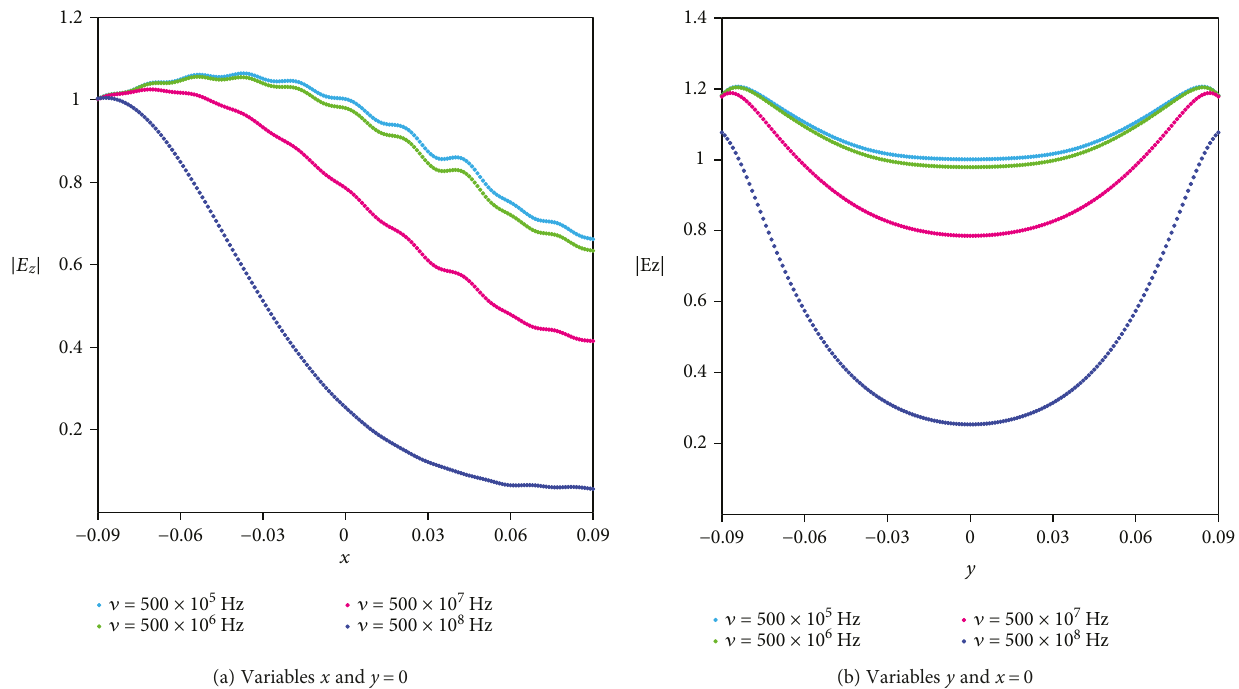
Figure 19: Magnitude of the electric fi eld, in volts/meter, inside the plasma for linear cuts through the cylinder obtained by the FDTD simulation for di ff erent collision frequencies ν . Incident wave frequency is set to f n =5 × 10 17 m − 3 0